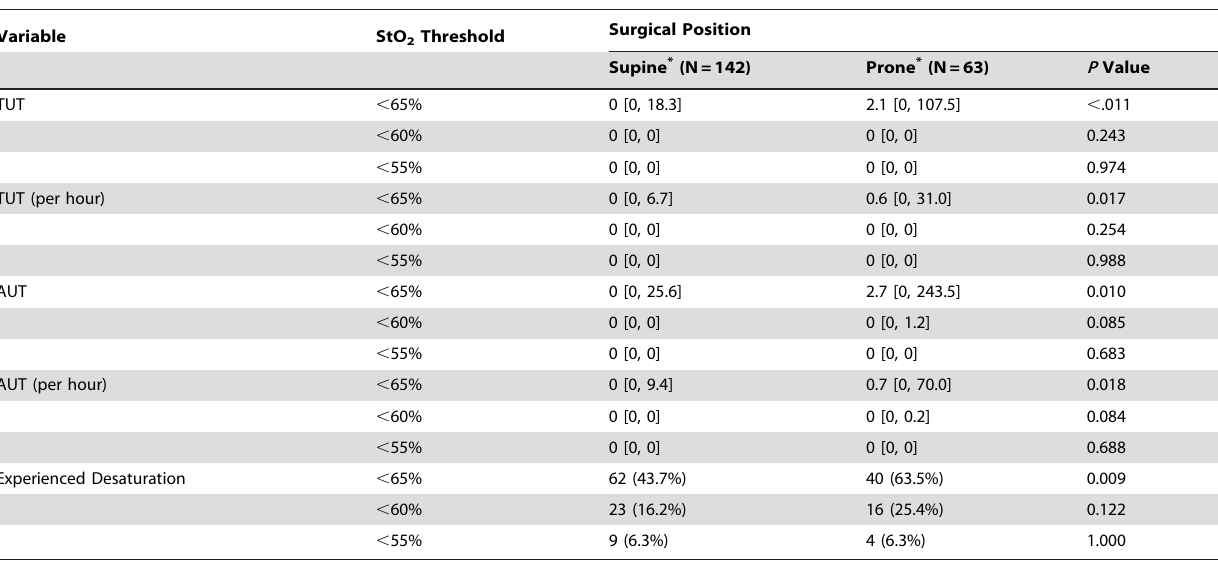
Table 3. Supine vs. Prone: Comparison of Desaturation at 3 Thresholds.